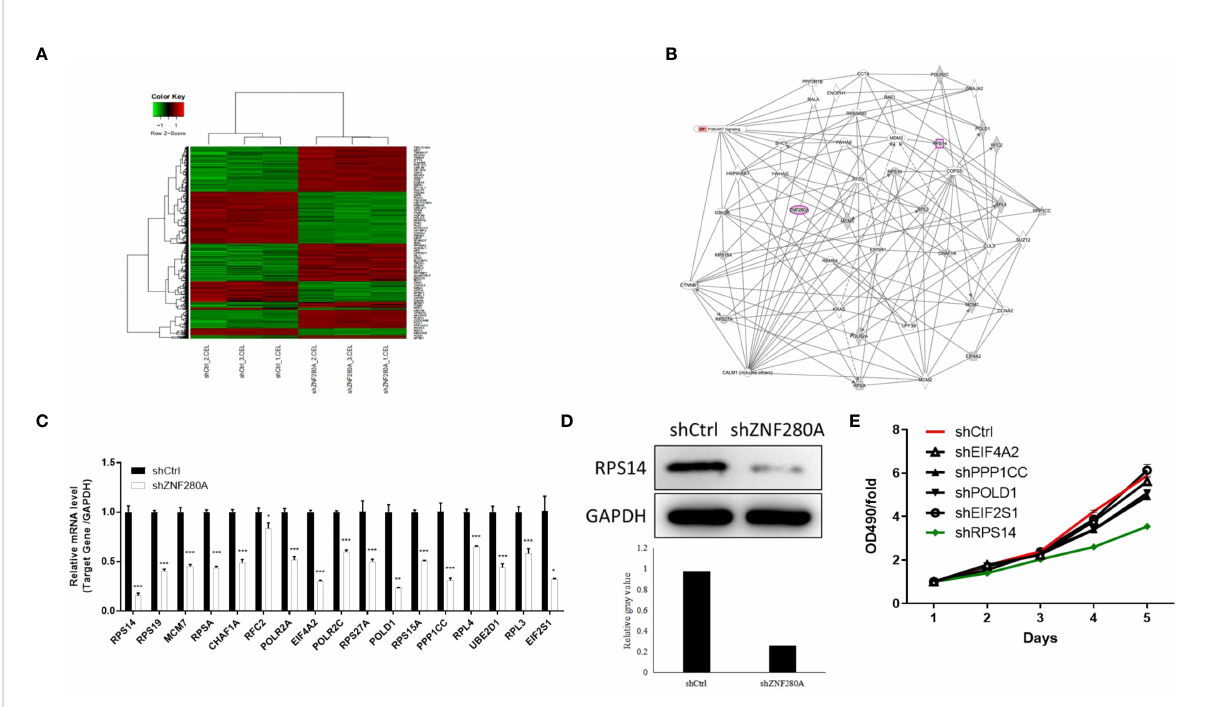
FIGURE 4 RPS14 is the downstream target of ZNF280A in the regulation of CRC. (A) A PrimeView Human Gene Expression Array was performed to identify the DEGs between shZNF280A and shCtrl groups of RKO cells. (B) A ZNF280A associated interaction network constructed by IPA analysis revealed the potential linkage between ZNF280A and RPS14. (C – E) Real-time PCR (C) , western blotting (D) and MTT (E) analyses were used to detect the expression of several selected DEGs in RKO cells with or without ZNF280A. *P < 0.05, **P < 0.01, ***P <